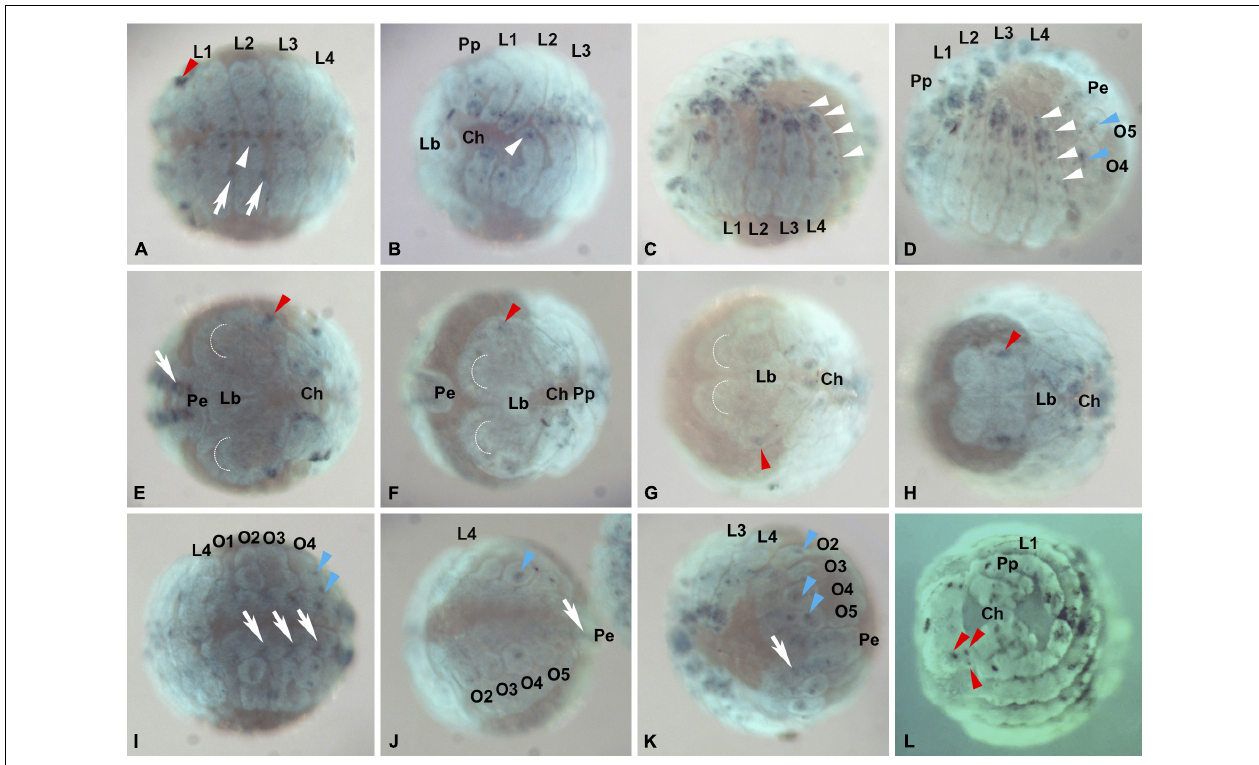
FIGURE 2 | Pax2.1 ( aug3.g762 ) expression in P. tepidariorum embryos. Expression of Pt-Pax2.1 is detected beginning with brain differentiation (Stage 10, A,E,I ) and expression stays throughout inversion (Stage 11, B,F,J ), dorsal (Stage 13, C,G,K ) and early and late ventral closure (stage 14, D,H,L ). (A–D) Ventral view of embryos in different developmental stages. Pt-Pax2.1 is expressed in prosomal and opisthosomal appendages (white and blue arrowheads, respectively) and the ventral neuroectoderm (white arrows). (E–H) Frontal view. Pt-Pax2.1 is expressed in the head lobes next to the lateral furrow (red arrowheads E–G ) during brain differentiation, inversion, and dorsal closure (stages 10–13). Later during ventral closure (Stage 14) Pt-Pax2.1 is expressed in the lateral eye primordia [red arrowhead in (H) depicting the primordial cluster, three red arrowheads in (L) depicting the three distinct eye primordia]. (I–K) Ventral view of the developing opisthosoma. Pt-Pax2.1 is expressed in the opisthosomal ventral neuroectoderm (white arrows) and developing opisthosomal appendages (blue arrowheads). Anterior is to the left in all panels, all images show ventral aspect, except (E–H,L) which are in frontal aspect. Dotted half circles indicate the anterior furrow in the prechelceral head